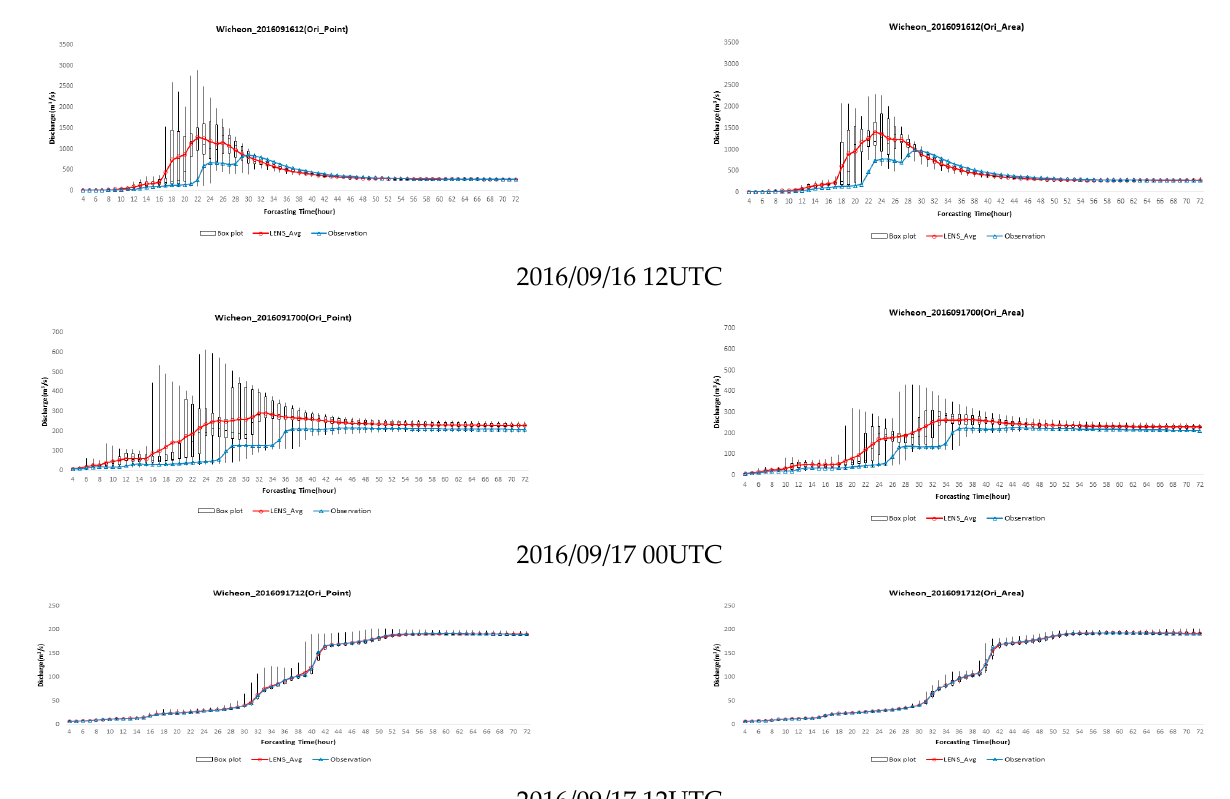
Figure 12. Wicheon Original GRM Discharge (GRM. W Ori ). Table 11. Likelihood of behavioral models.